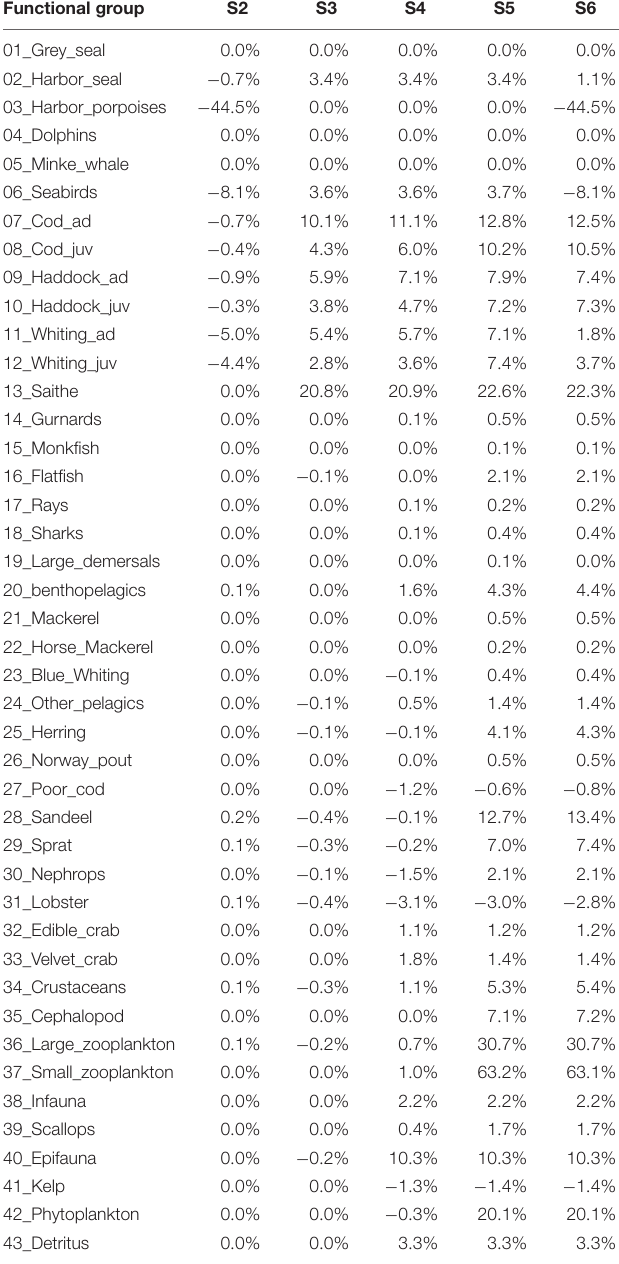
TABLE 3 | Mean relative annual biomasses changes (2011–2013) of functional group across scenario 1–6. Functional